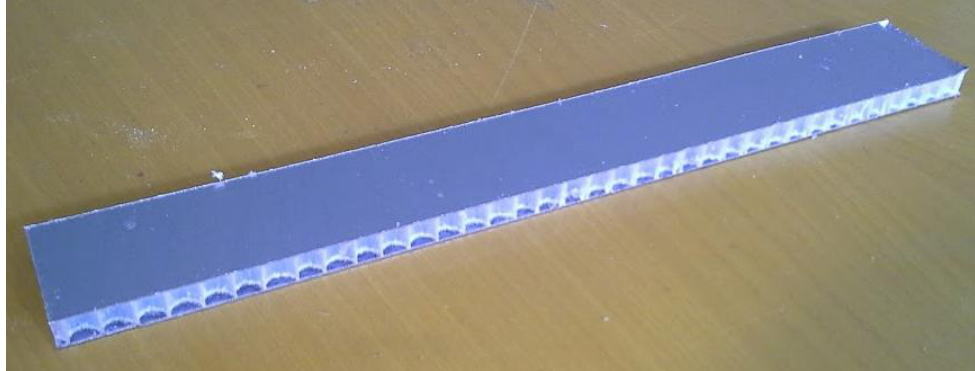
Figure 5. Sample c1 prior testing.